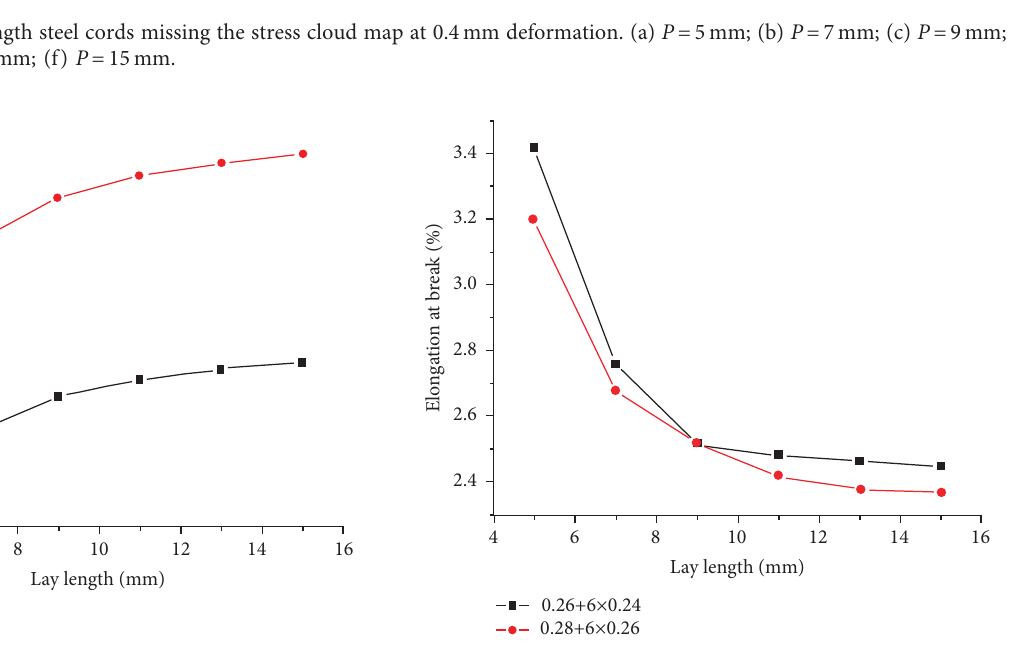
Figure 6: 0.26 +6 × 0.24 steel cord and 0.28+6 × 0.26 steel cord breaking force change curve with lay length.